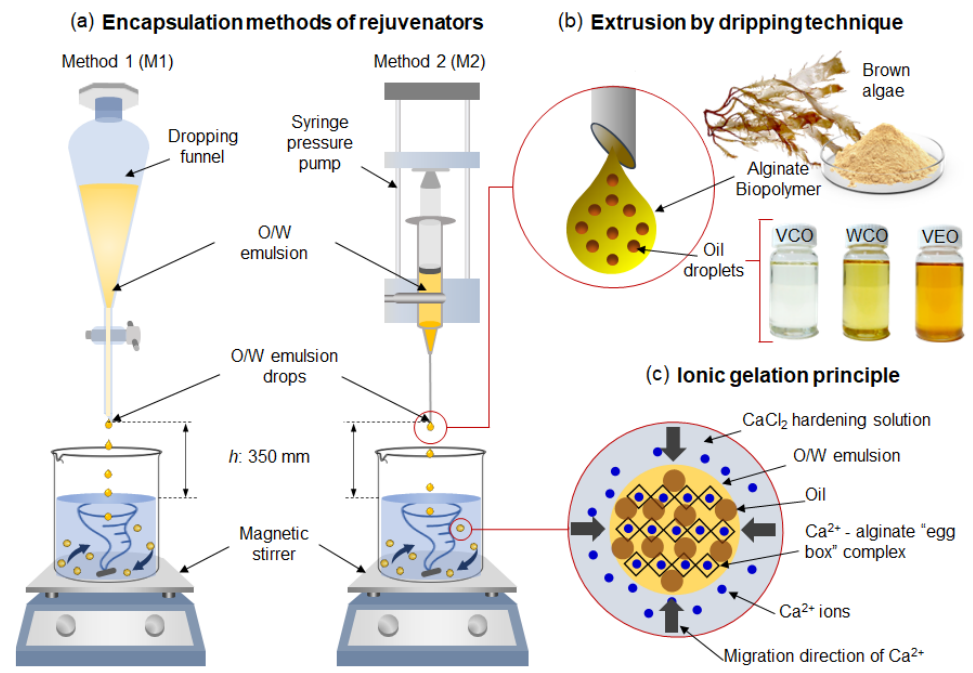
Figure 1. Scheme of the synthesis of the capsules under ( a ) dropping funnel and syringe pump methods. ( b ) Extrusion and releasing of an oil-in-water emulsion droplet. ( c ) Ca 2+ migration and reaction with the alginate biopolymer by ionic gelation principle, forming the well-known Ca–alginate egg-box complex. As a result, the oil is encapsulated in the biopolymeric internal structure.